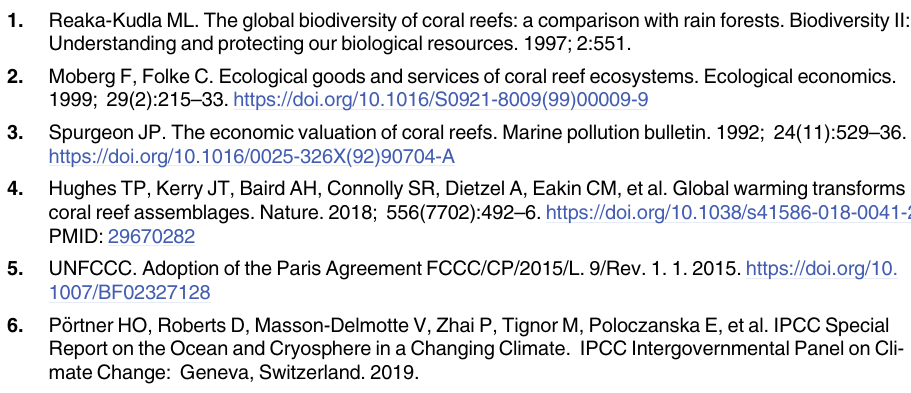
S6 Table. Mean percentage cover and standard deviation of 44 coral genera. Summary of all studied sites along the Kenyan coast. S7 Table. Mean density of coral size classes (number of colonies per 100m 2 ). Summary of all studied sites along the Kenyan coast. S8 Table. PERMANOVA main-test table of results. S1 Fig. Illustration of the four habitat types occurrence at the three geographical zones. North zone has three habitat types one of them uniquely to this zone (DEPR); Central zone has three habitat types, one it shares with all other zones (SPC), another with only north (SFLPR) and only south zone (DEFU); South zone has only two habitat types, one it shares with all zones (SCP) and the other with only Central zone